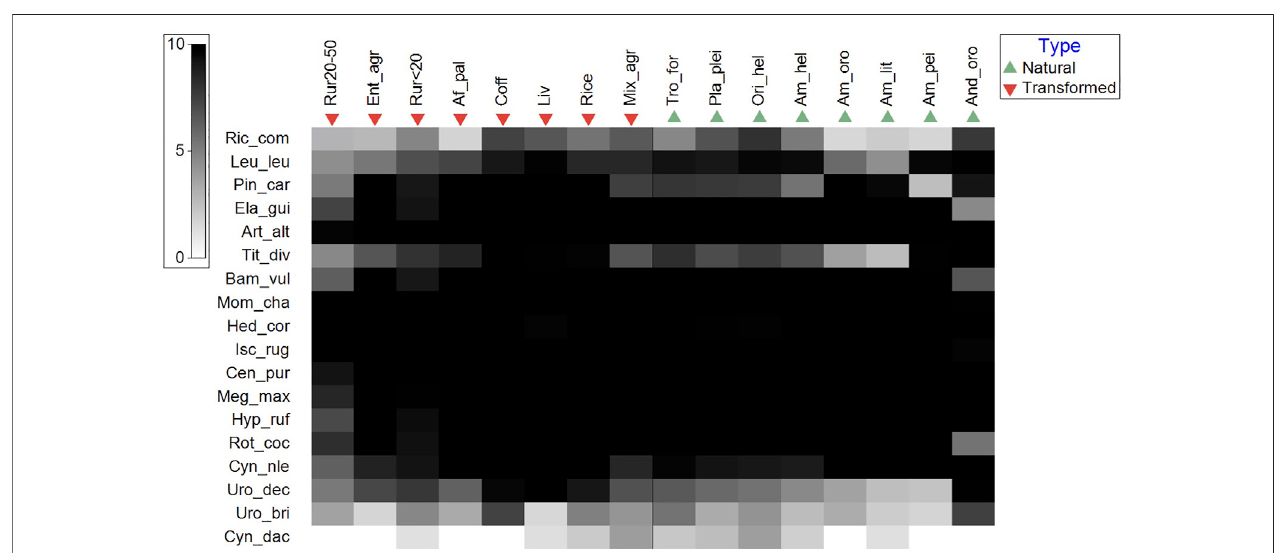
FIGURE 3 | Heat map of Whittaker (1952) association index of 18 exotic plant species concerning 16 natural biomes and transformed ecosystems in the Orinoco region.